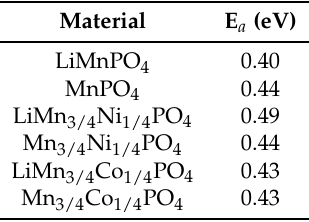
Table 3. Barrier activation energies (E a ) in eV for the pristine and doped systems. In lithiated structures, the values refer to Li vacancy diffusion; in delithiated structures, the data refer to Li ion